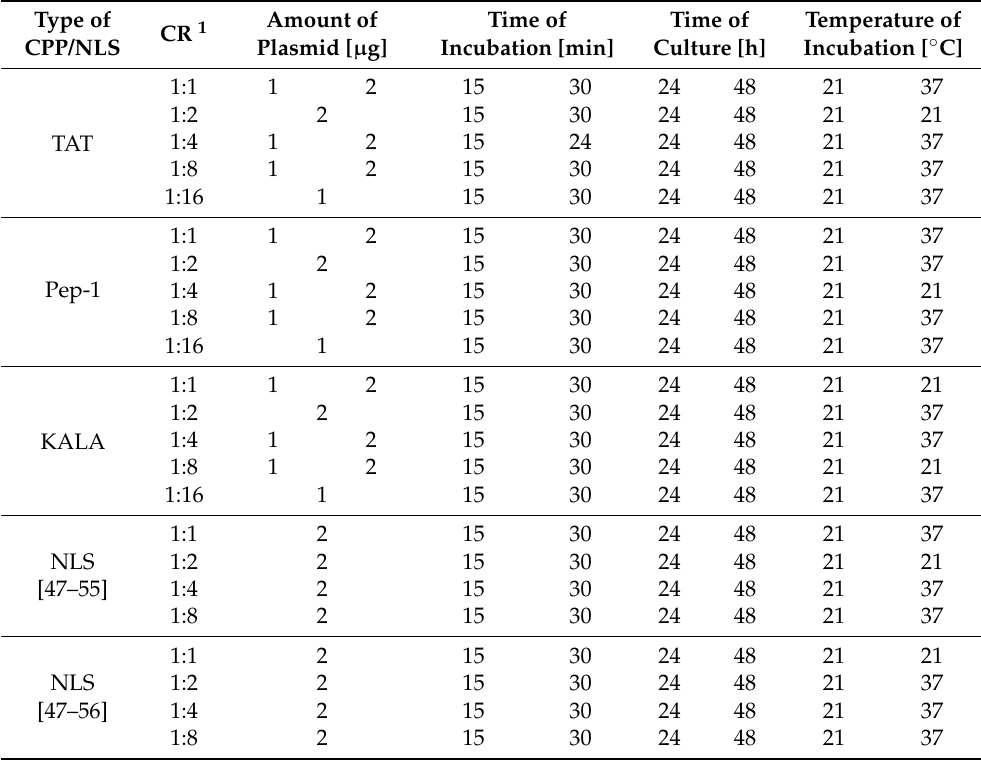
Table 1. Conditions of CPP-cargo complexes